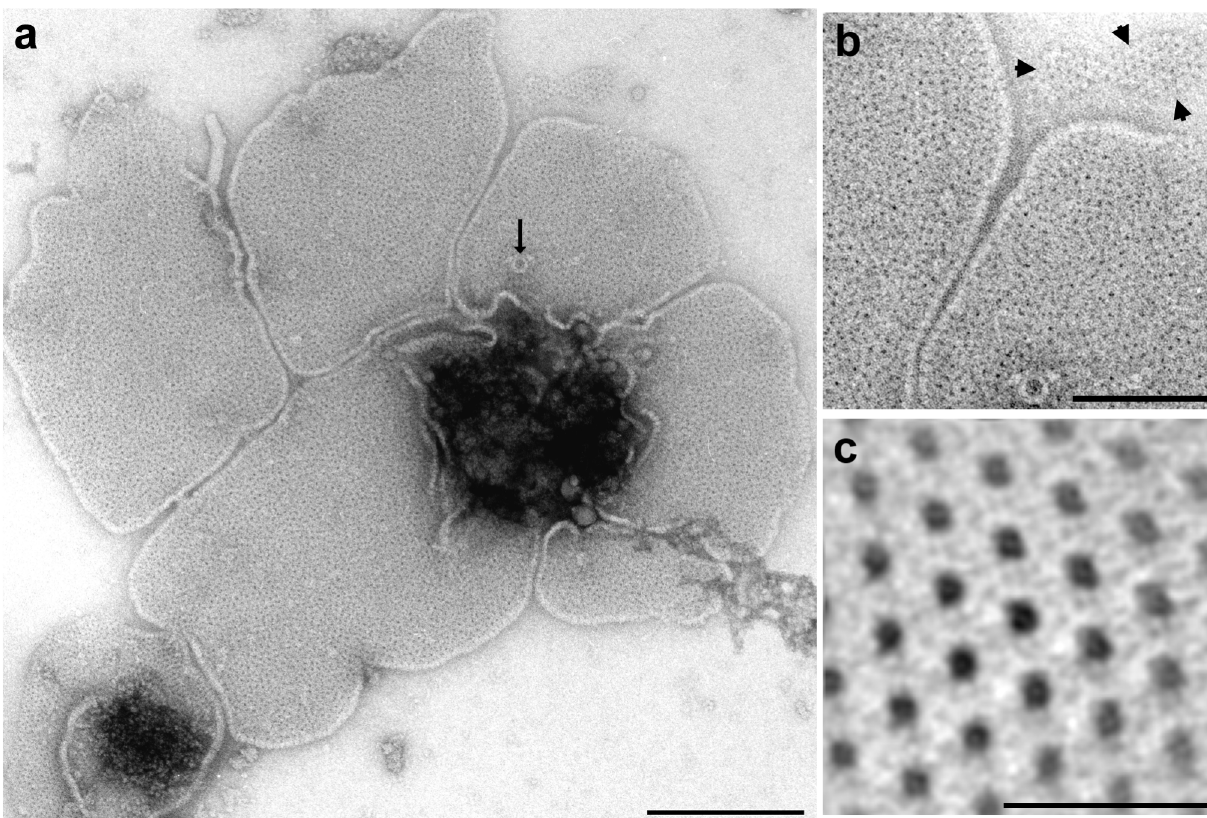
Figure 5. Electron micrograph showing a preparation enriched in outer membranes of Ignicoccus after density gradient centrifugation and nega- tive staining with uranyl acetate. (a) Five mostly double-layered membrane patches; arrow: 24-nm pore; bar = 200 nm. (b) Detail of (a), contrast enhanced, at higher magnification; three arrowheads in the top right corner outline a small single-layered patch; bar = 100 nm. (c) Correlation av- erage of the small single-layered patch marked in (b); dark: negative stain; bar = 20